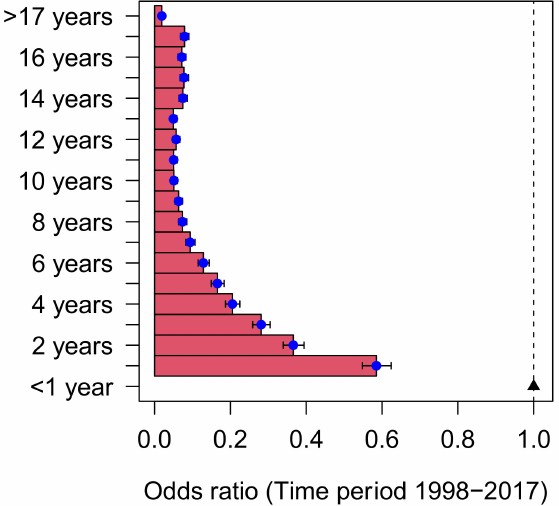
Figure 2. Odds ratio for hospitalization across the pediatric age group (infants <1 year used as